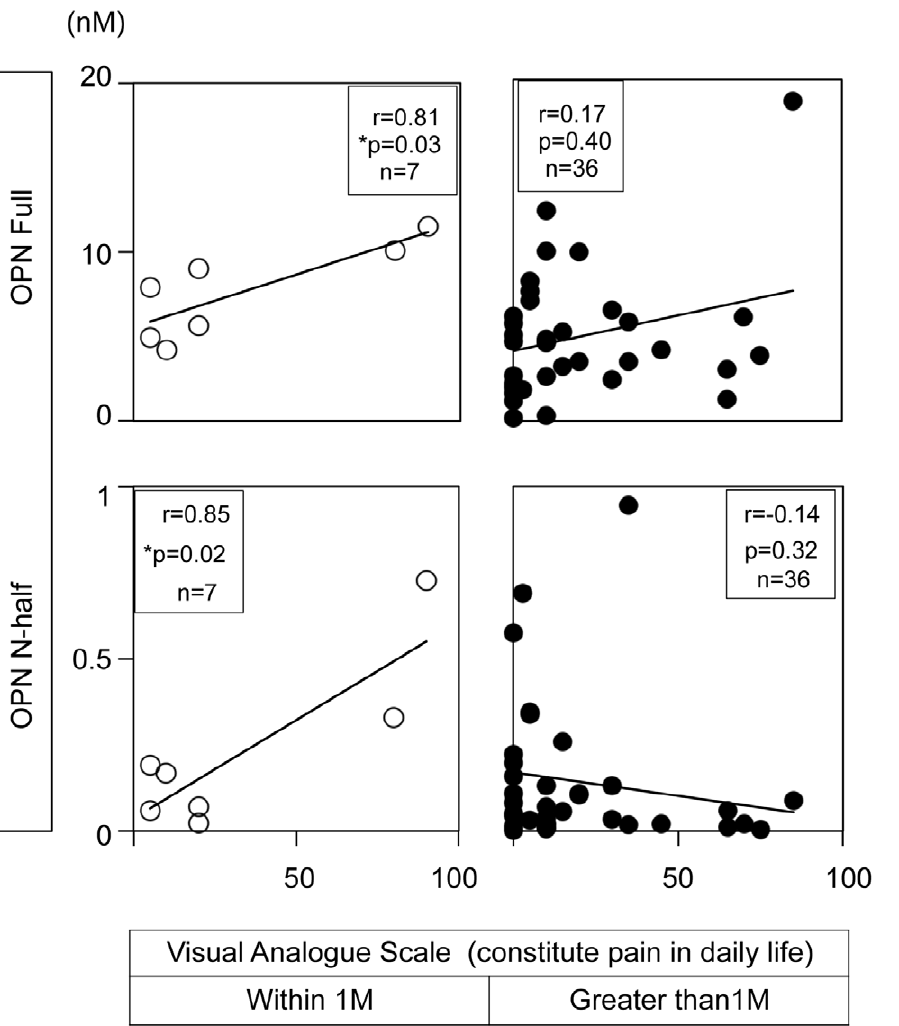
Figure 3. OPN Full and N-half levels in synovial fluid are positively correlated with the severity of joint pain within a month after ACL rupture. VAS indicating constitutive pain in a daily life (see Table S2) was collected in the examination room before consultation. Open circle; VAS from patients within 1 month after ACL rupture. Closed circle; VAS from patients who ruptured ACL greater than 1 month ago. Number of samples, correlation coefficient, and p value are indicated in each